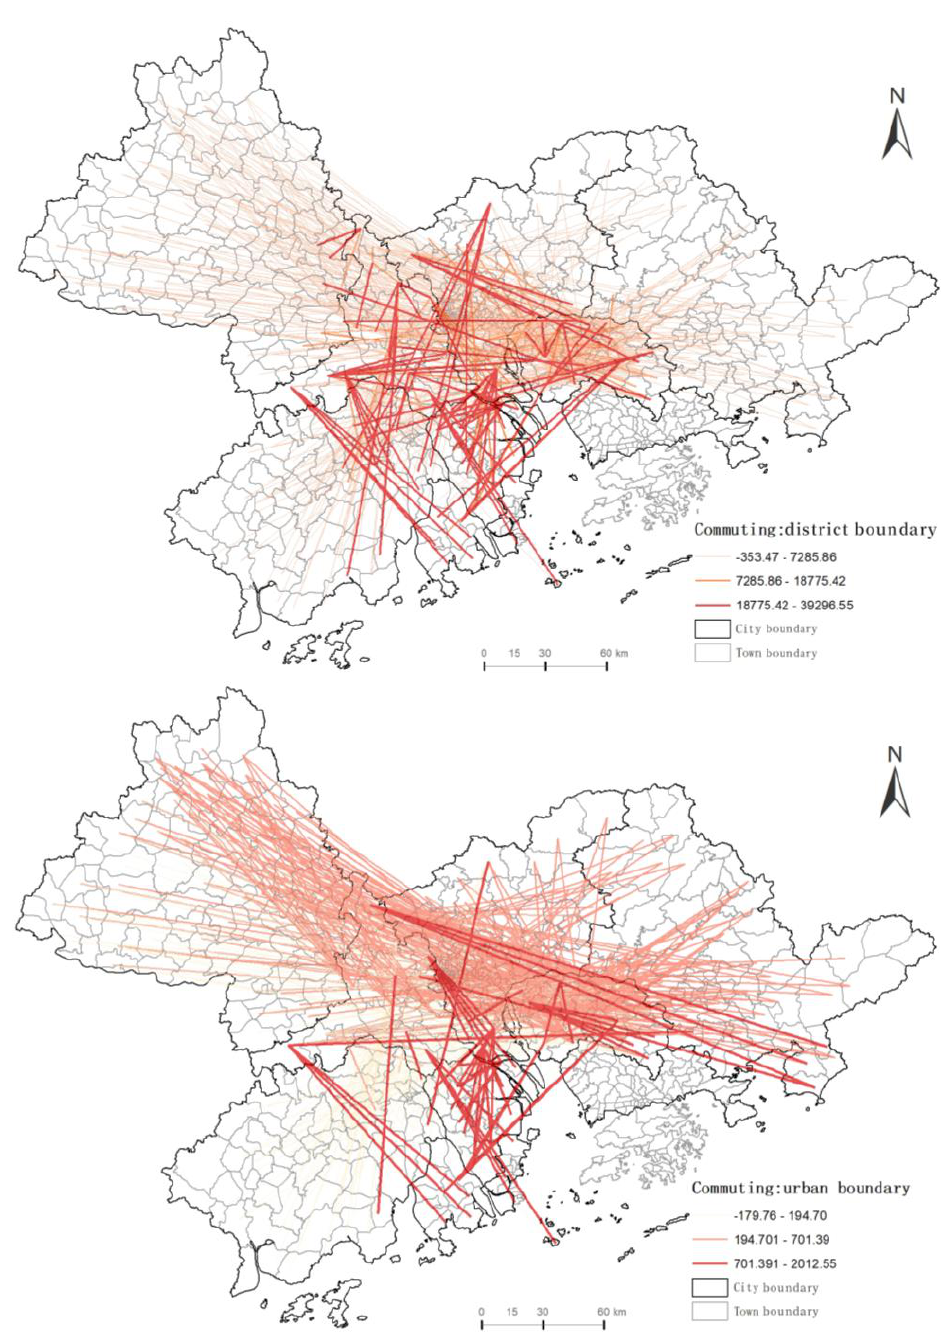
Figure 3. The local effect of administration division on rural mobility for commuting.